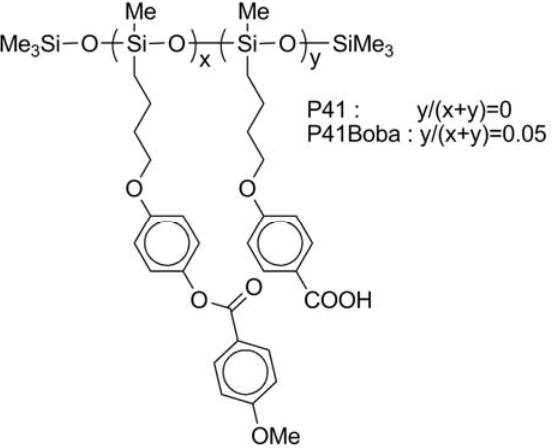
Figure 1. Structure of the liquid crystalline